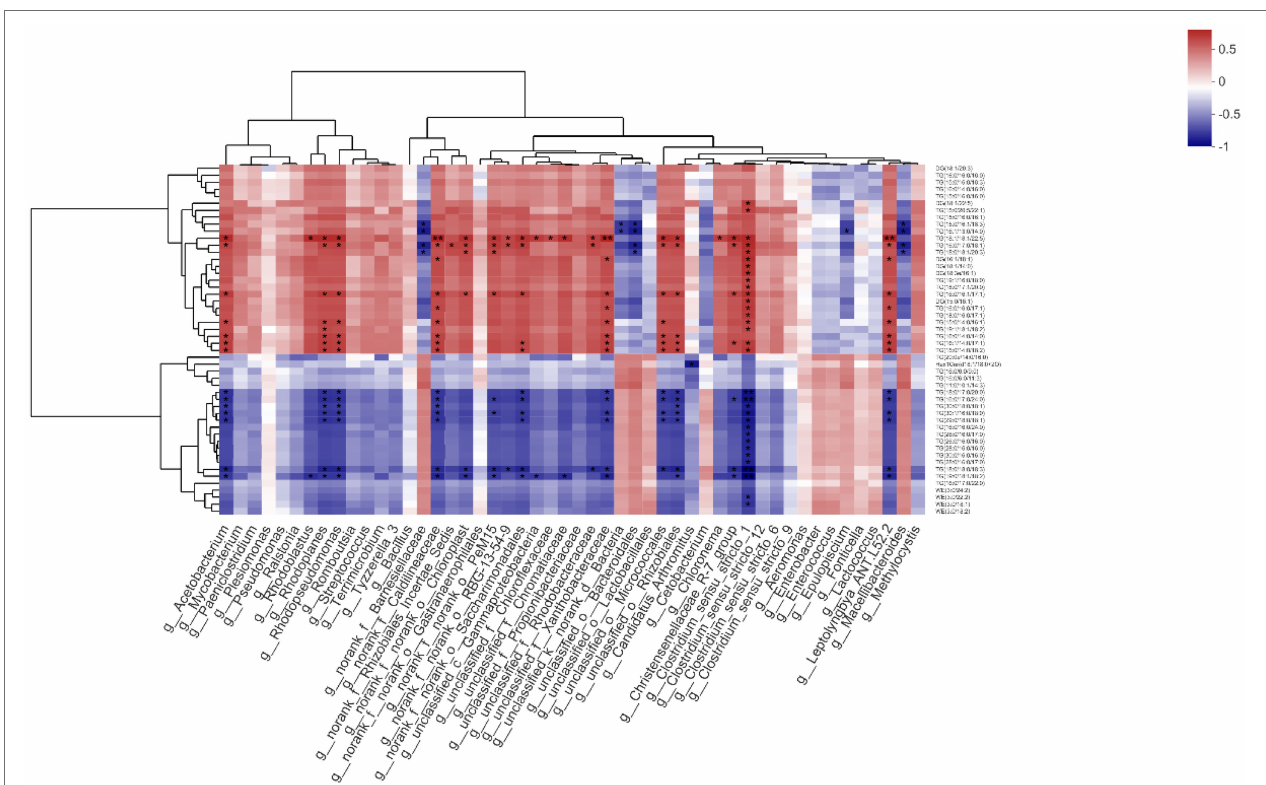
FIGURE 9 | Effects of methionine restriction on the correlations between specific microbiota and lipids after feeding for 8 weeks ( n = 3); * p < 0.05 and ** p <